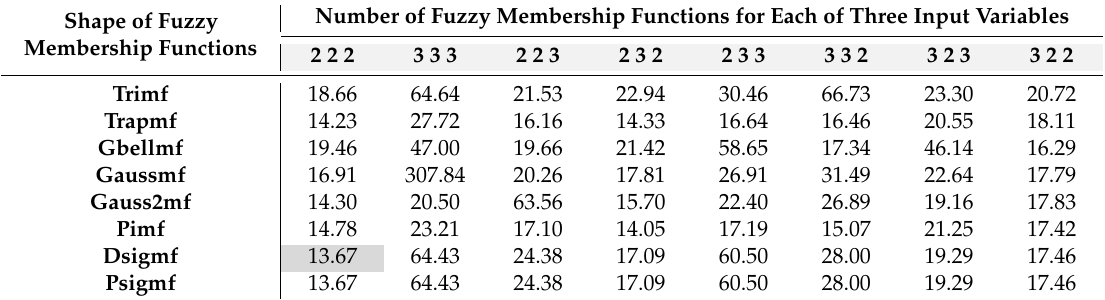
Table 5. The values of average testing errors of different ANFIS models with constant output. Shape of Fuzzy